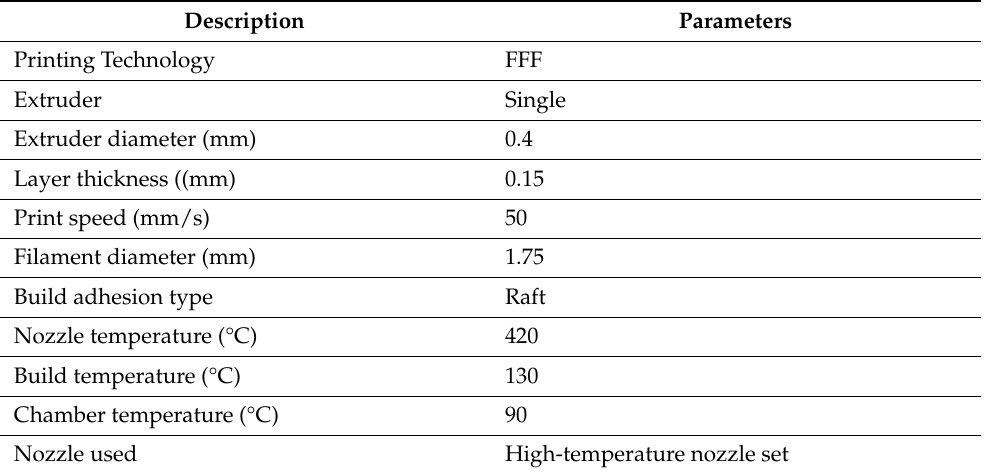
Table 3. Process parameters in the fabrication of the PEEK implant using the FUNMAT HT